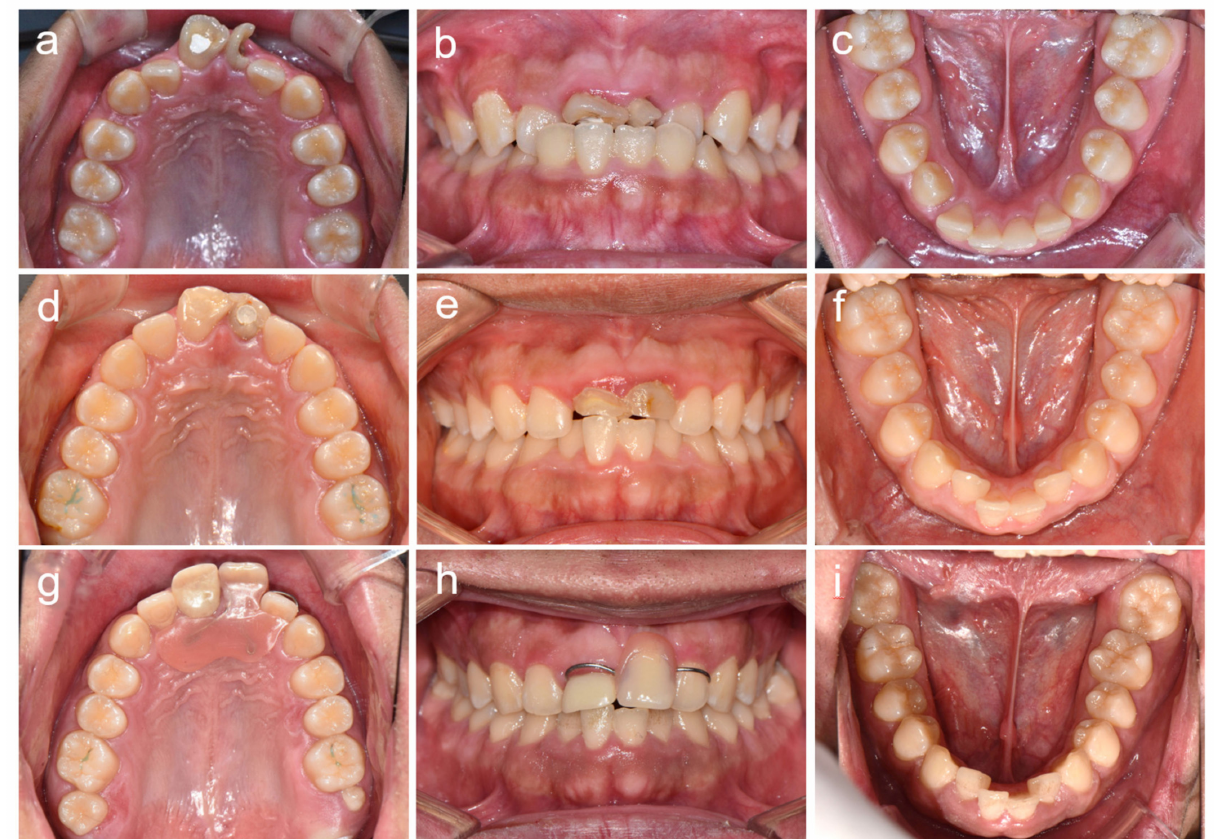
Figure 2. Clinical photos of patient 1. ( a – c ) Clinical photos at age 11 years 3 months. ( d – f ) Clinical photos at age 13 years 7 months. ( g – i ) Clinical photos at age 19 years 1 month.